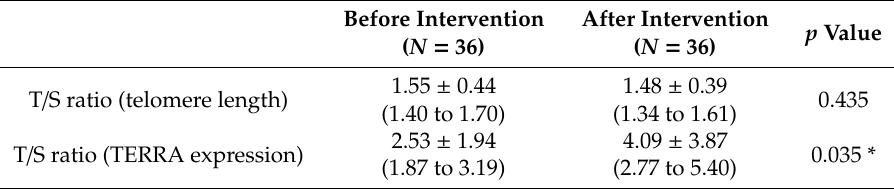
Table 3. Association of the T / S ratio of the telomere length and TERRA expression with old age ( ≥ 65 years), sarcopenia and intervention using exercise and nutrition support. Age (Year) Sarcopenia Intervention Female Gender Telomere length